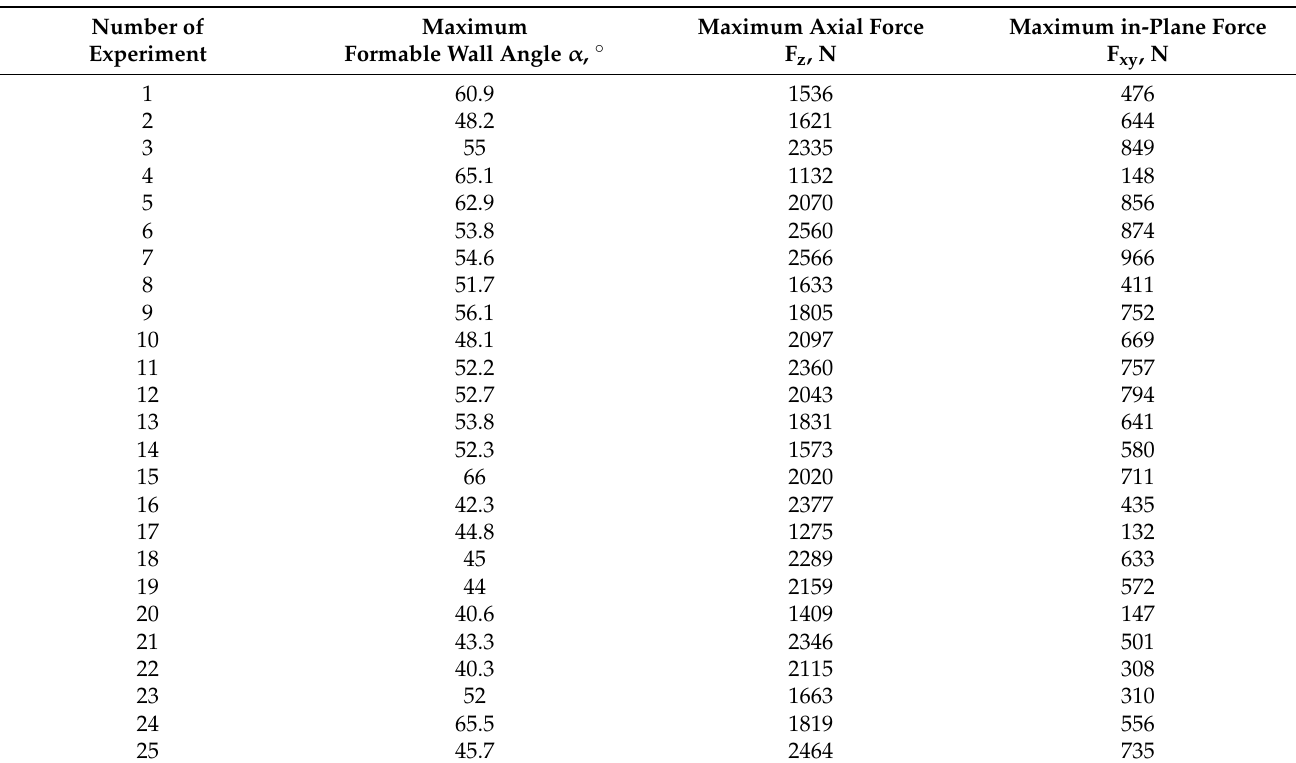
Table 4. Results of the SPIF